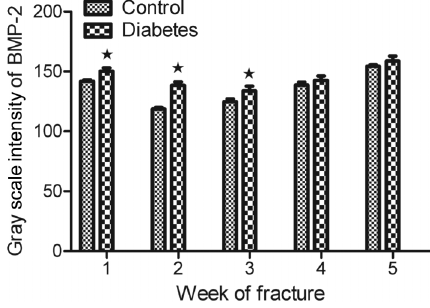
Figure 5. Gray scale intensity of bone morphogenetic protein-2 (BMP-2) in the two groups. The gray scale intensity value of BMP-2 expression was higher in the diabetes group than in the control group at postoperative weeks 1, 2, and 3. The differences between the two groups was signi fi cant (*P o 0.05, t